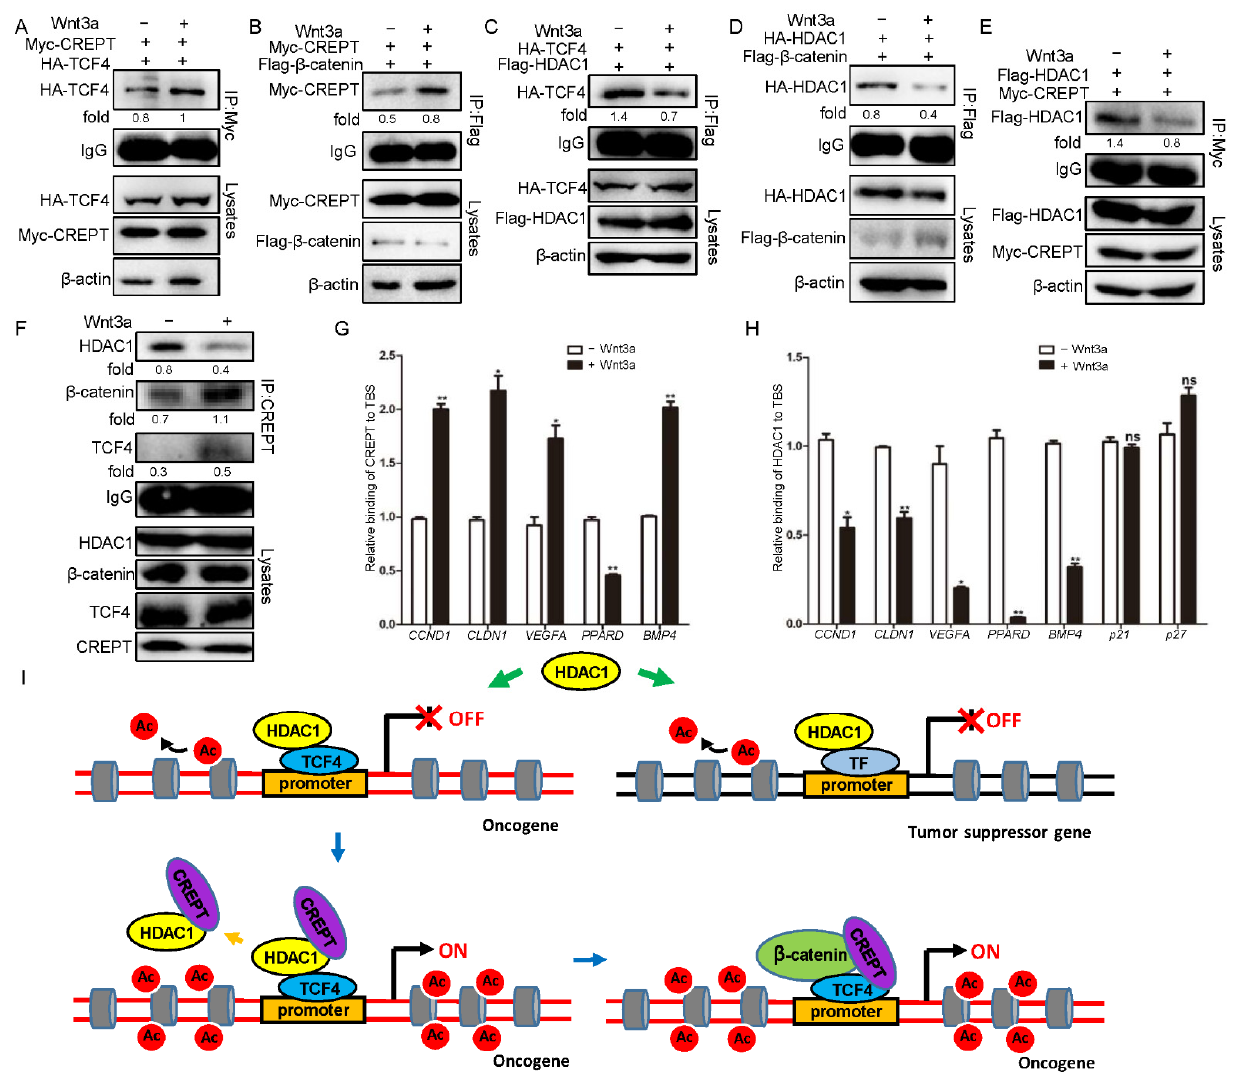
Figure 6. Wnt3a induces CREPT but reduces HDAC1 binding TBS. ( A , B ). Wnt3a increases the inter ‐ action between CREPT and TCF4 ( A ) ‐β‐ catenin ( B ) complex. Myc–CREPT (3 ug), HA–TCF4 (3 ug) ( A ) or Flag– β‐ catenin (3 ug) ( B ) were co ‐ transfected in HEK293T cells. Then, Wnt3a was added for 20 h. ( C , D ). Wnt3a represses the interaction between HDAC1 and TCF4 ( C )/ β‐ catenin ( D ) complex. Flag–HDAC1 (3 ug), HA–TCF4 (3 ug) ( C ) or Flag– β‐ catenin (3 ug) ( D ) were co ‐ transfected cells with